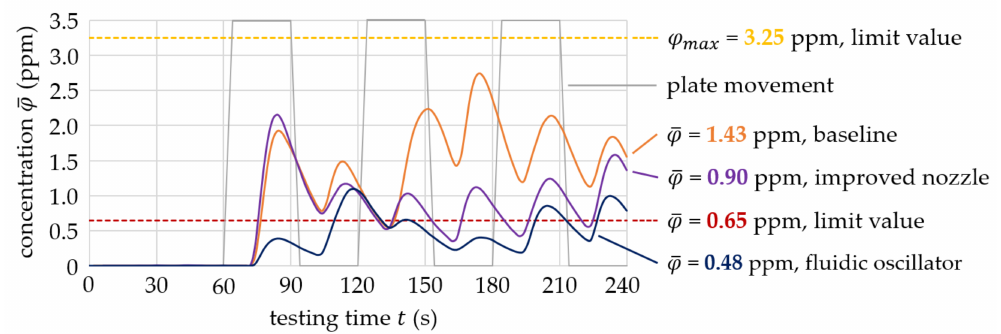
Figure 27. Robustness of containment at an extract volume flow rate of 320 m 3 /h. Fume hood with different nozzle